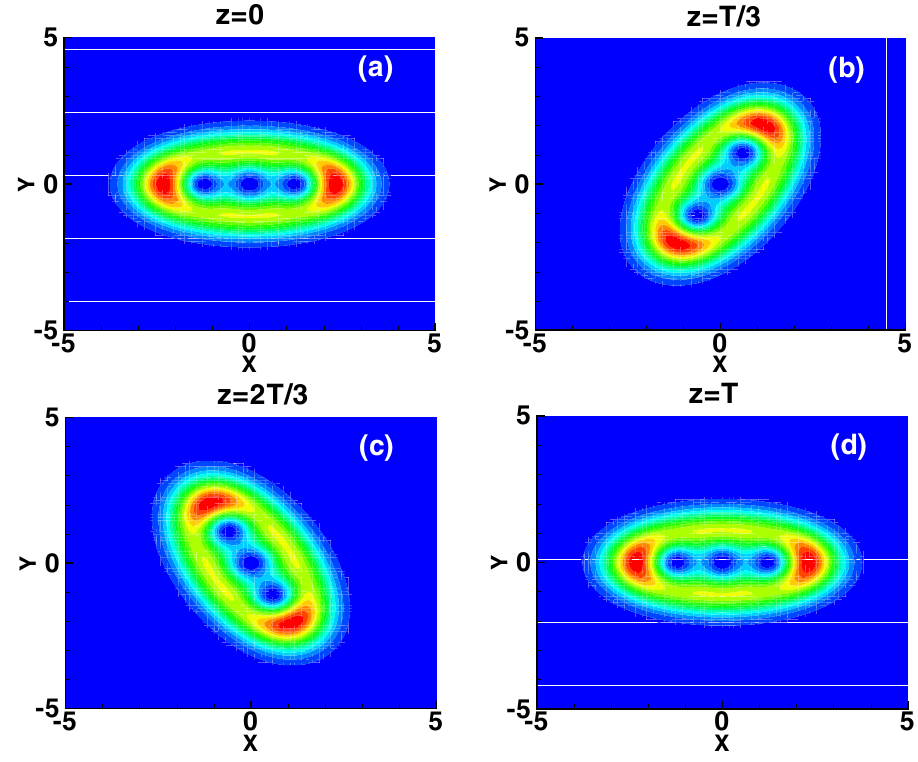
Figure 4. Evolution of the third-order mode of the spiraling elliptic Hermite-Gaussian